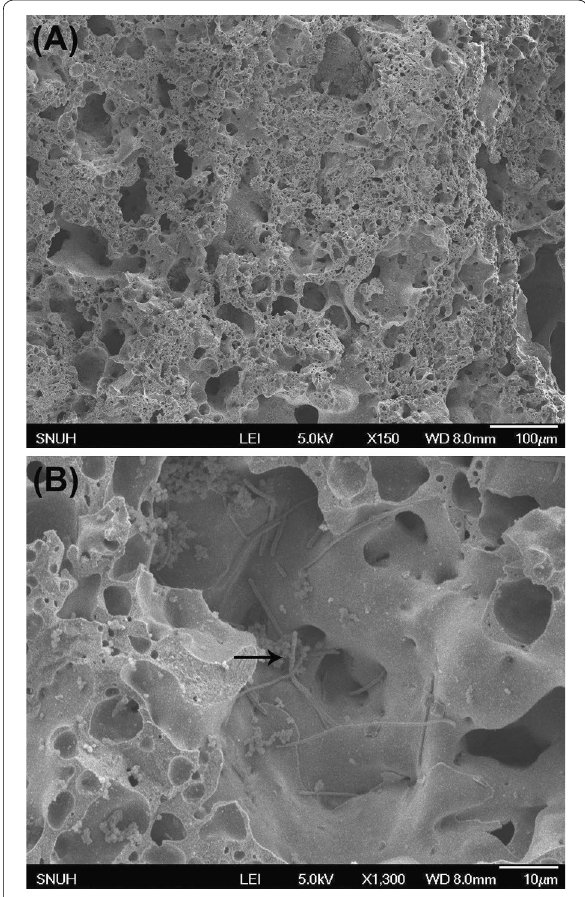
Fig. 1 Scanning electron microscope (SEM) images of expanded clay without bacteria YS11 ( A ) and with bacteria YS11 ( B ). Arrow in B indicates bacteria YS11 of bar shape